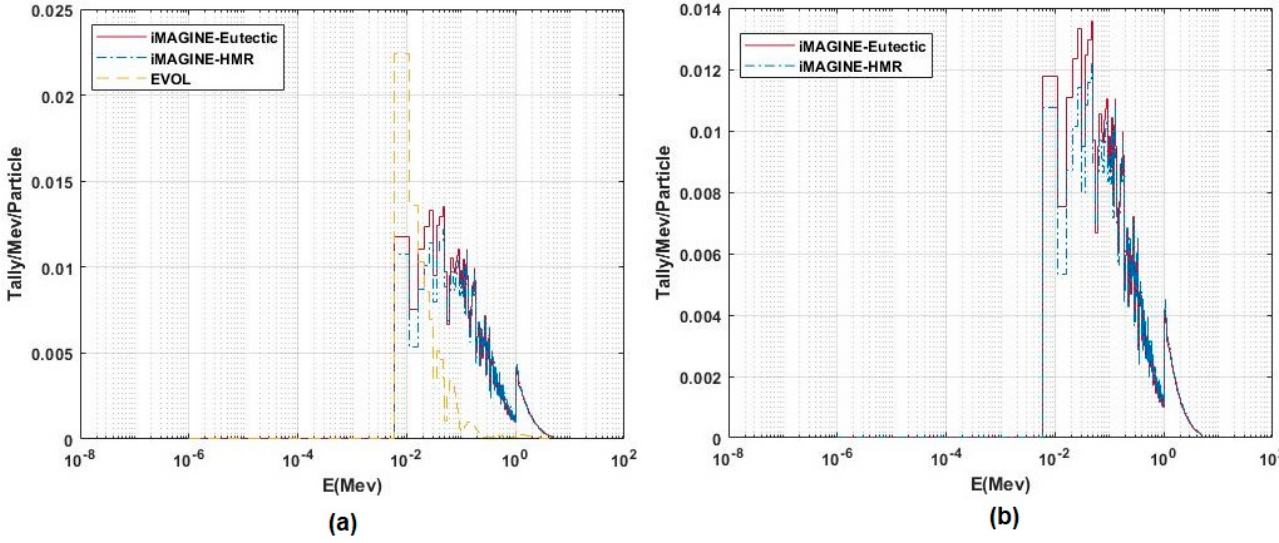
Figure 9. Comparative neutron-flux energy spectrum of iMAGINE and EVOL salt fuel systems.